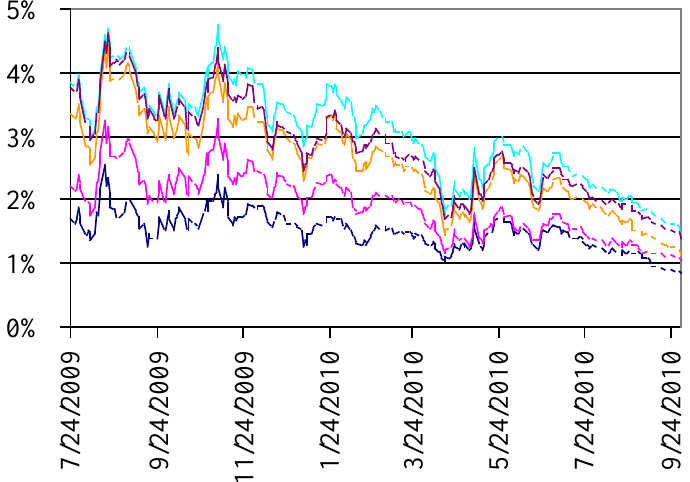
Figure 2. AAA credit spreads in percent for five vintages of the CMBX index plotted from 24 July 2009, to 30 September 2010. The figure plots the credit spreads in percent implied by various vintages of the CMBX AAA indexes owned by Markit. The figure plots the credit spreads from the date of the first Term Asset-Backed Securities Loan Facility (TALF) sponsored purchase of Commercial Mortgage-backed Securities (CMBS) on 24 July 2009, until 30 September 2010. These are the rates that a credit protection buyer, credit default swap (CDS) buyer, must pay to insure a given amount of the referenced securities. Almost all of the collateral for TALF loans are rated AAA or Aaa by Standard & Poor’s and Moody’s, respectively. The CMBX allows investors to take long or short positions in a basket of 25 different tranches of various ratings and vintages of issue. The top line tracks the credit spreads of the fourth vintage of the CMBX AAA index launched in late 2007. The next-highest line plots the CMBX’s fifth AAA vintage launched in early 2008. The third highest line plots the credit spreads from the third vintage of the CMBX AAA index launched in early 2007. The second-to-the-bottom curve plots the credit spreads from the second vintage of the CMBX AAA index launched in the second half of 2006. The bottom line tracks the credit spreads from the first vintage of the CMBX AAA index launched on 7 March 2006. It is clear over this period credit spreads have generally declined, signaling declining fears of default risks on the AAA tranches of the referenced CMBS issues.